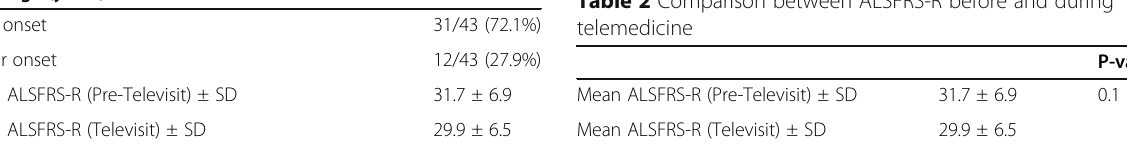
Table 2 Comparison between ALSFRS-R before and